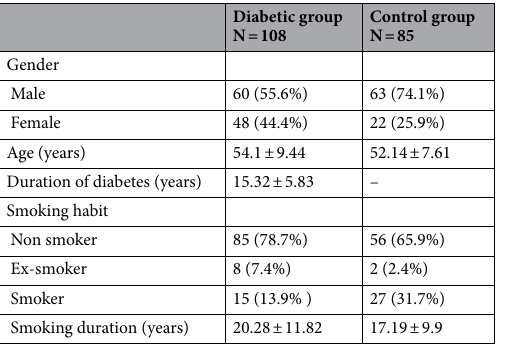
Table 1. Demographic data of participants in diabetic patients and control